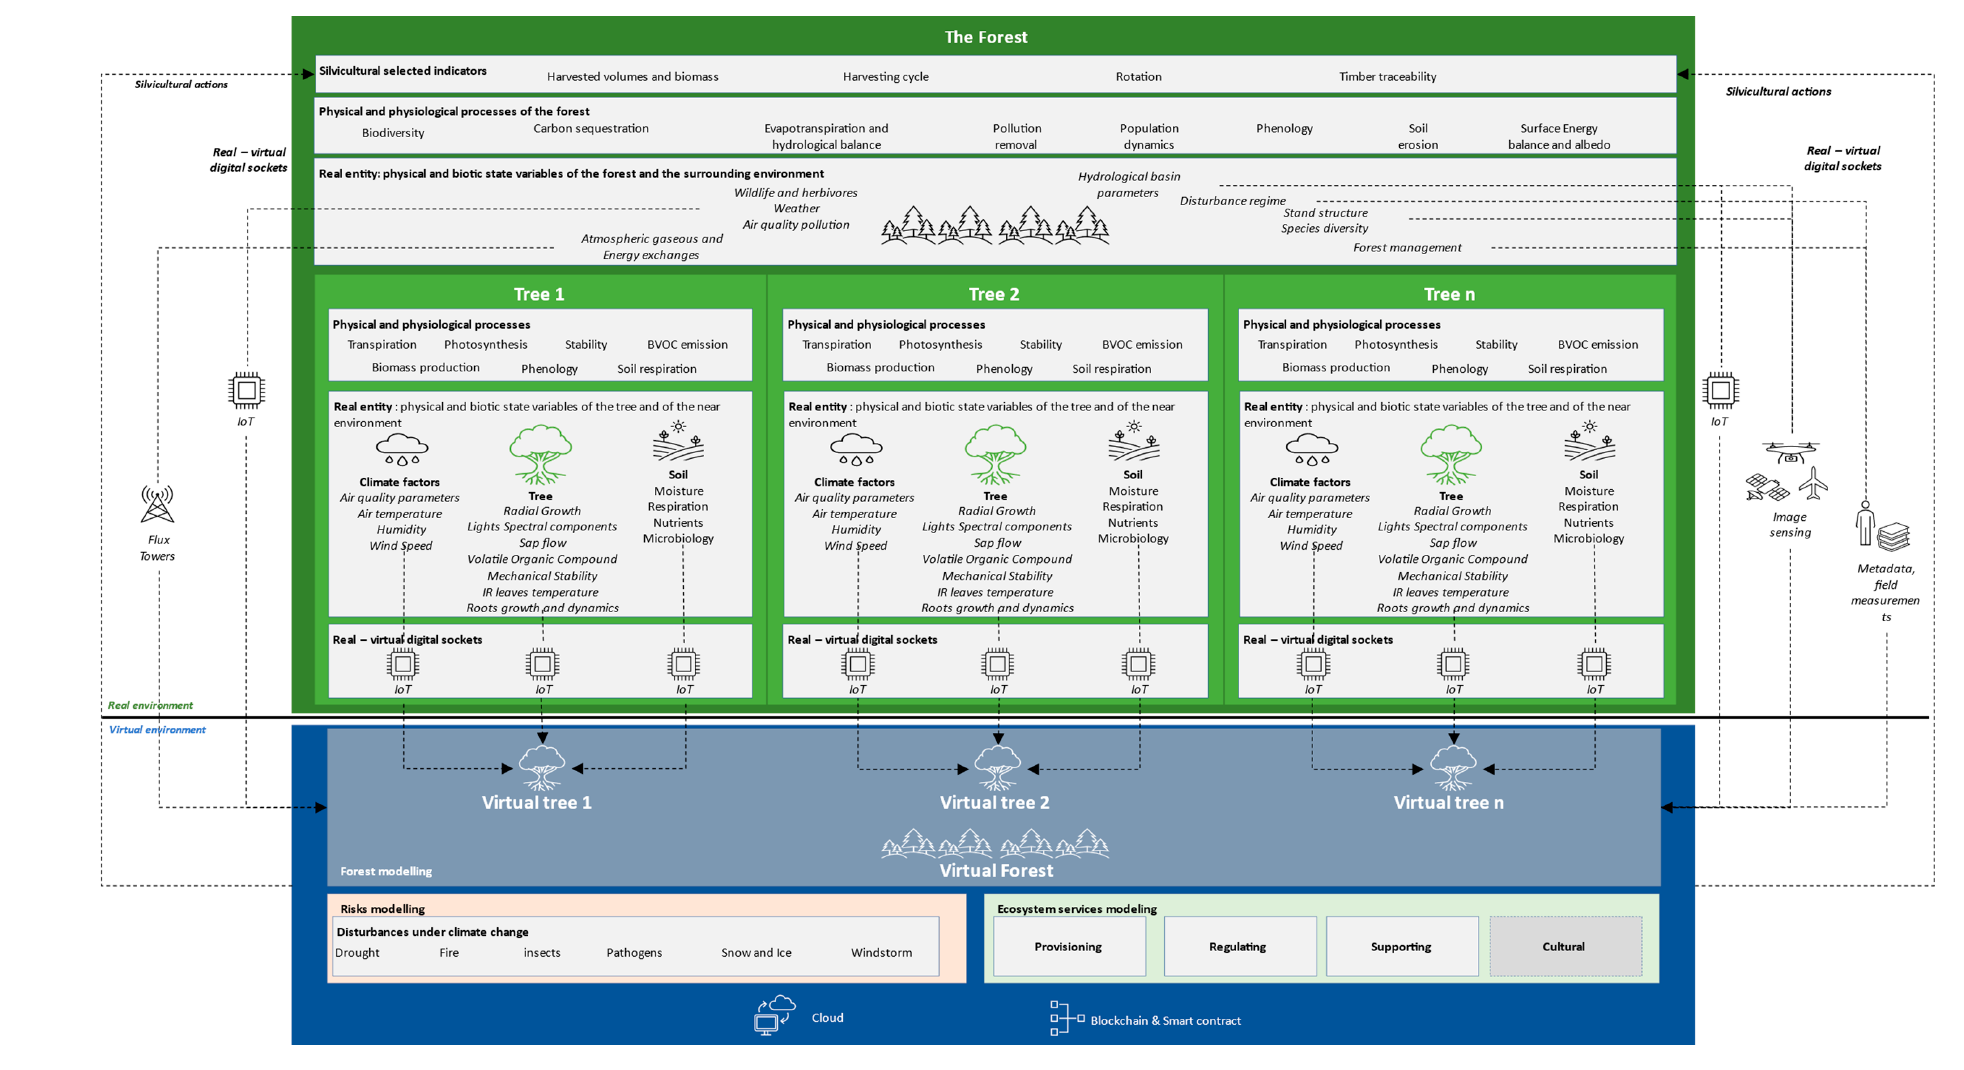
Figure 1. Forest digital twin framework.